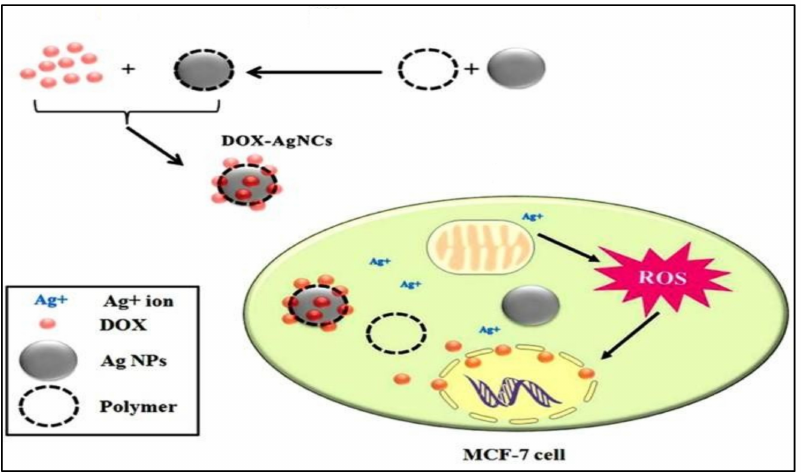
Figure 5. Schematic illustration of the possible mechanism of action behind the resultant synergic cytotoxic effect of DOX-loaded Ag/polymeric NCs on MCF-7 cells (Taken from open access journal under the terms of creative common attributes)